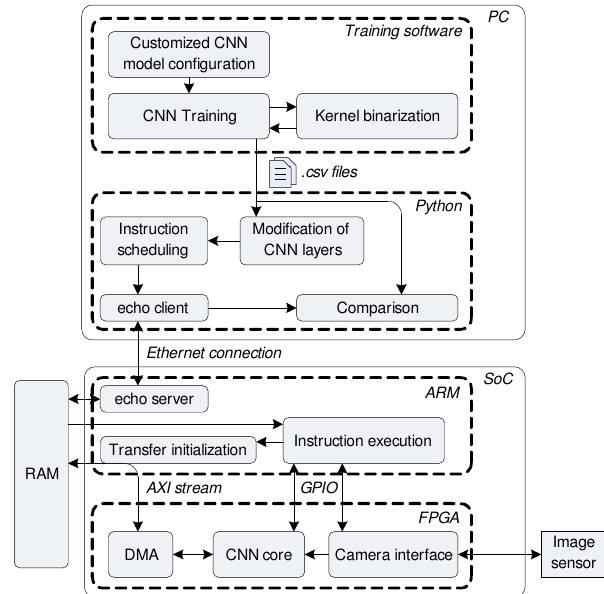
Figure 2. A schematic diagram of the complete process used to configure and place a CNN core of a custom convolutional neural network on a SoC FPGA